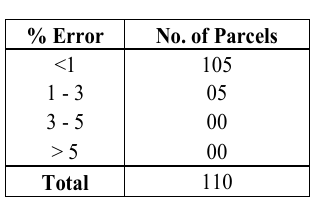
Table 3. Comparison Between updated RoR Records and ETS-GPS Parcels